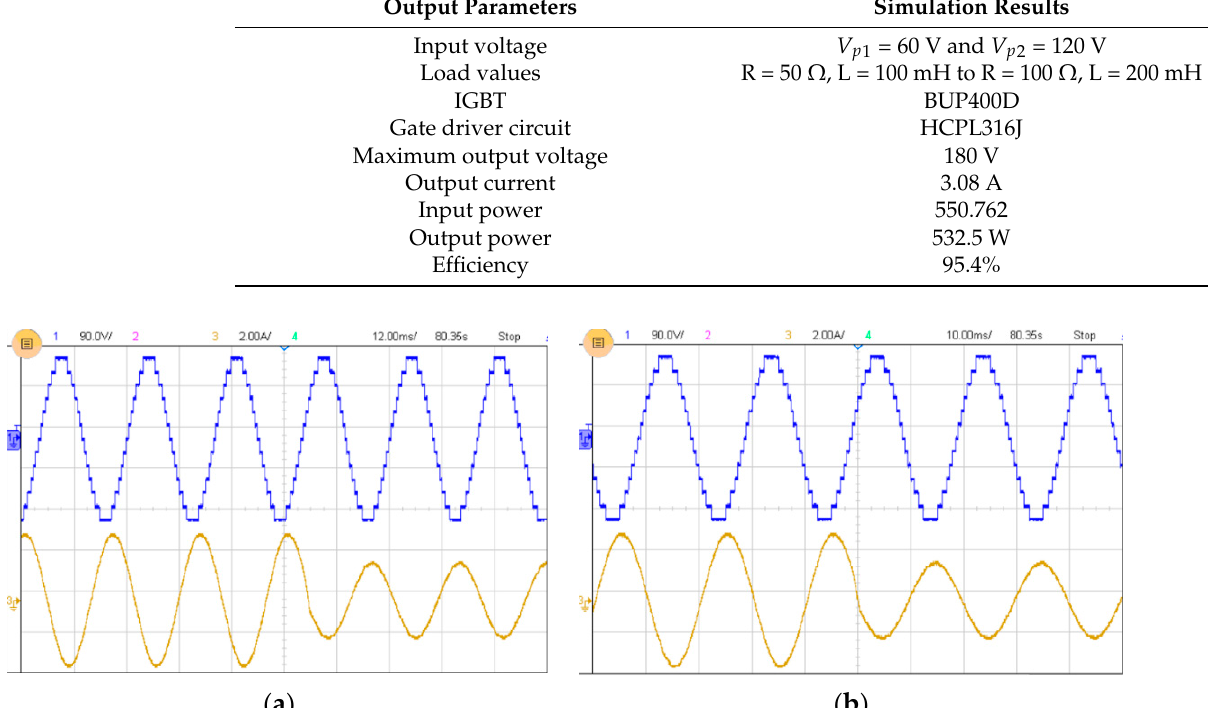
Figure 12. The experimental value of output voltage and current waveform in the 13-level inverter ( a ) with balancing load and ( b ) with load changes.